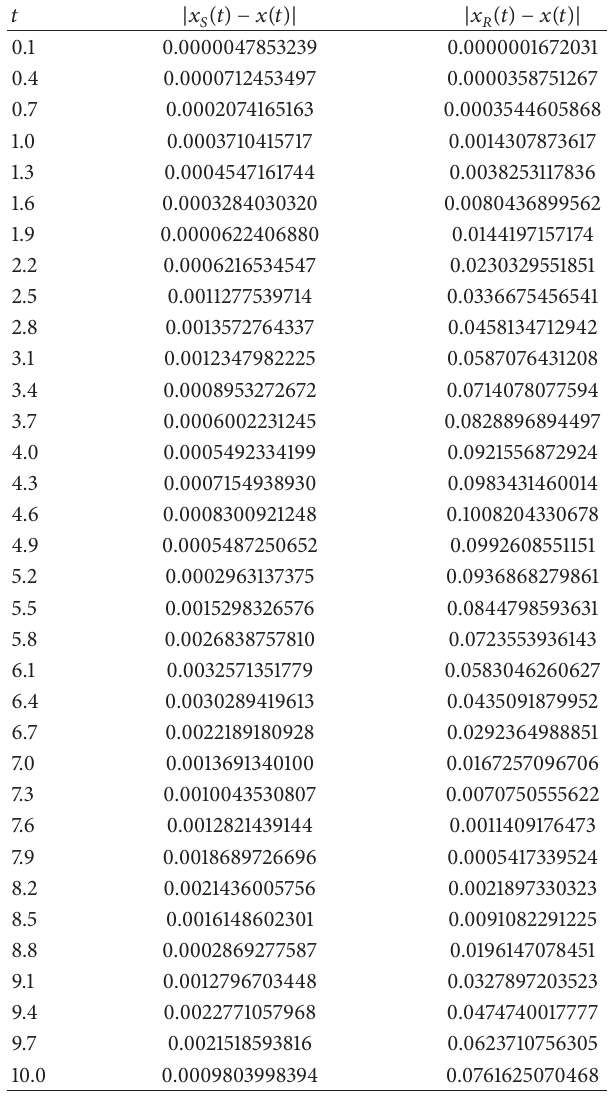
Table 2: Numerical error in the symbolic ( 𝑥 𝑆 (𝑡) ) and numeric ( 𝑥 𝑅 (𝑡) ) approximations, with respect to the exact solution 𝑥(𝑡)